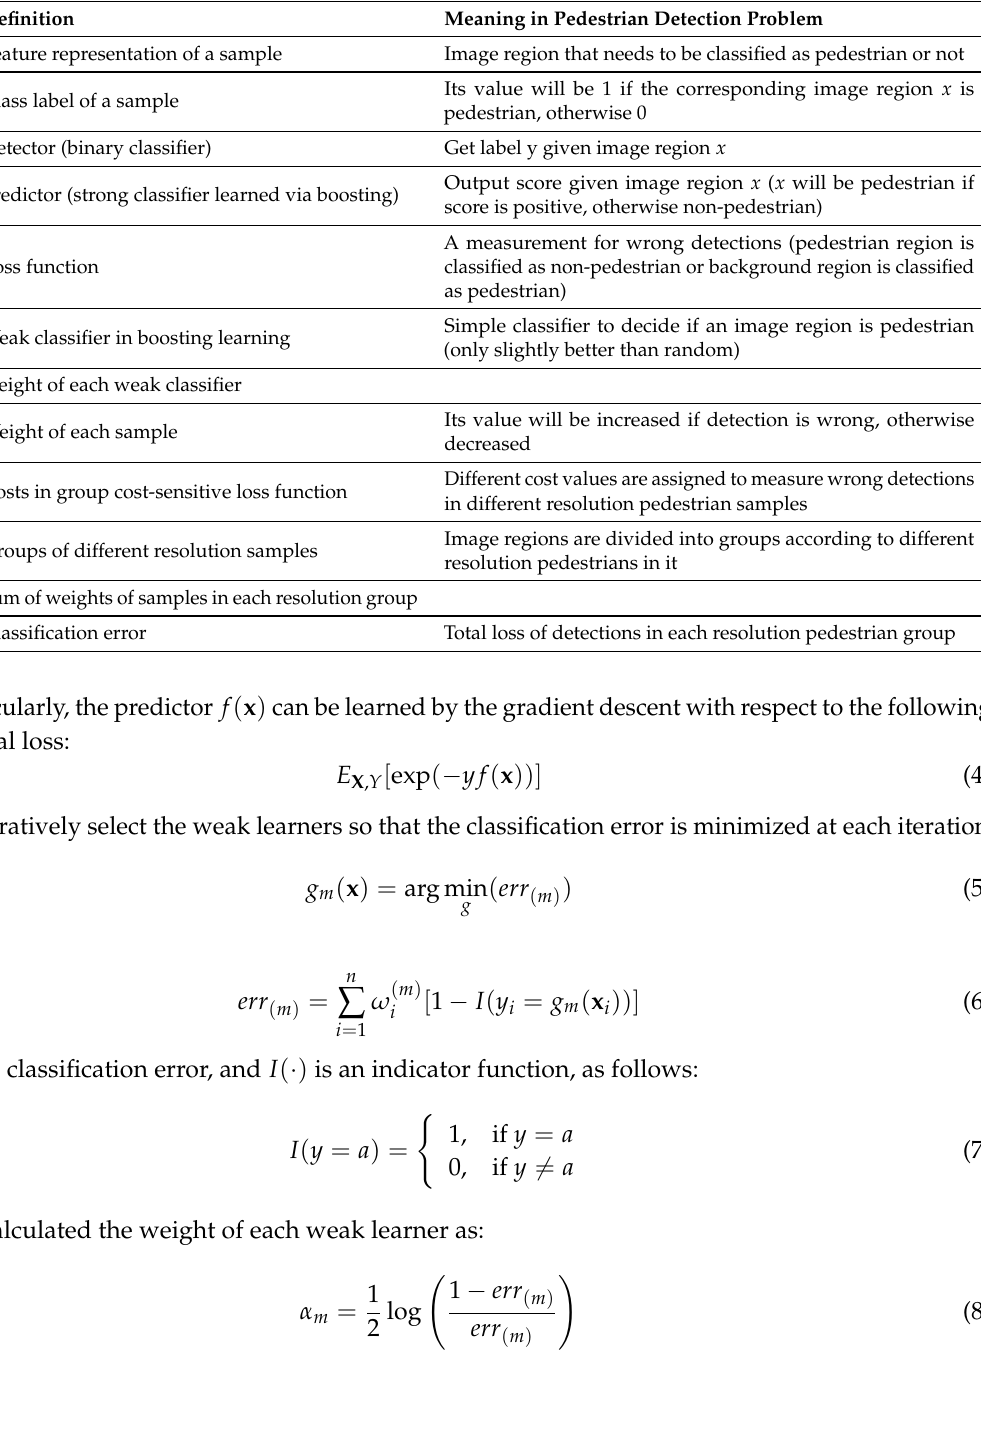
Table 1. A list of the terms that appear in our